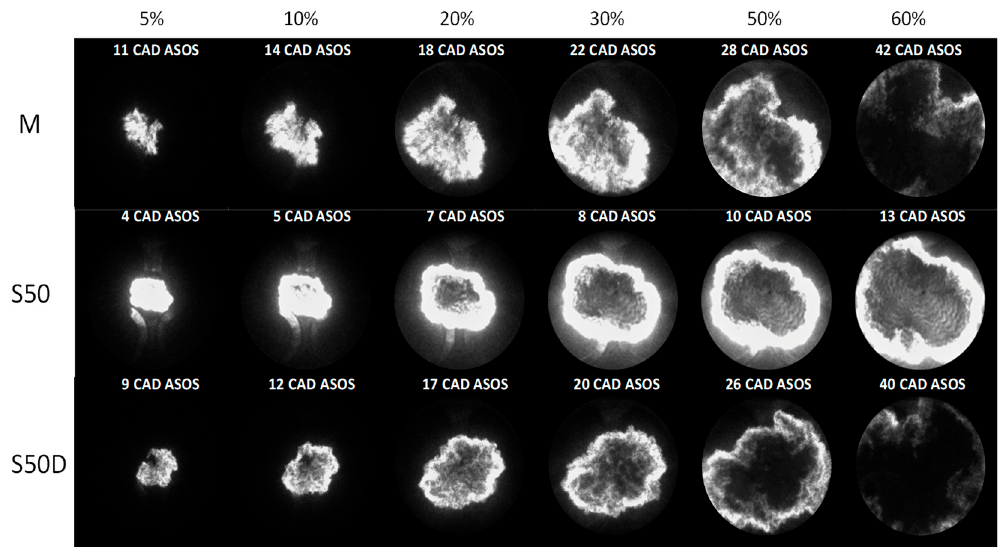
Figure 12. Image sequence of flame evolution at the same flame area (5%, 10%, 20%, 30%, 50% and 60% of the piston area) for a lean air-fuel ratio ( λ = 1.4) with M, S50, and S50D fueling.